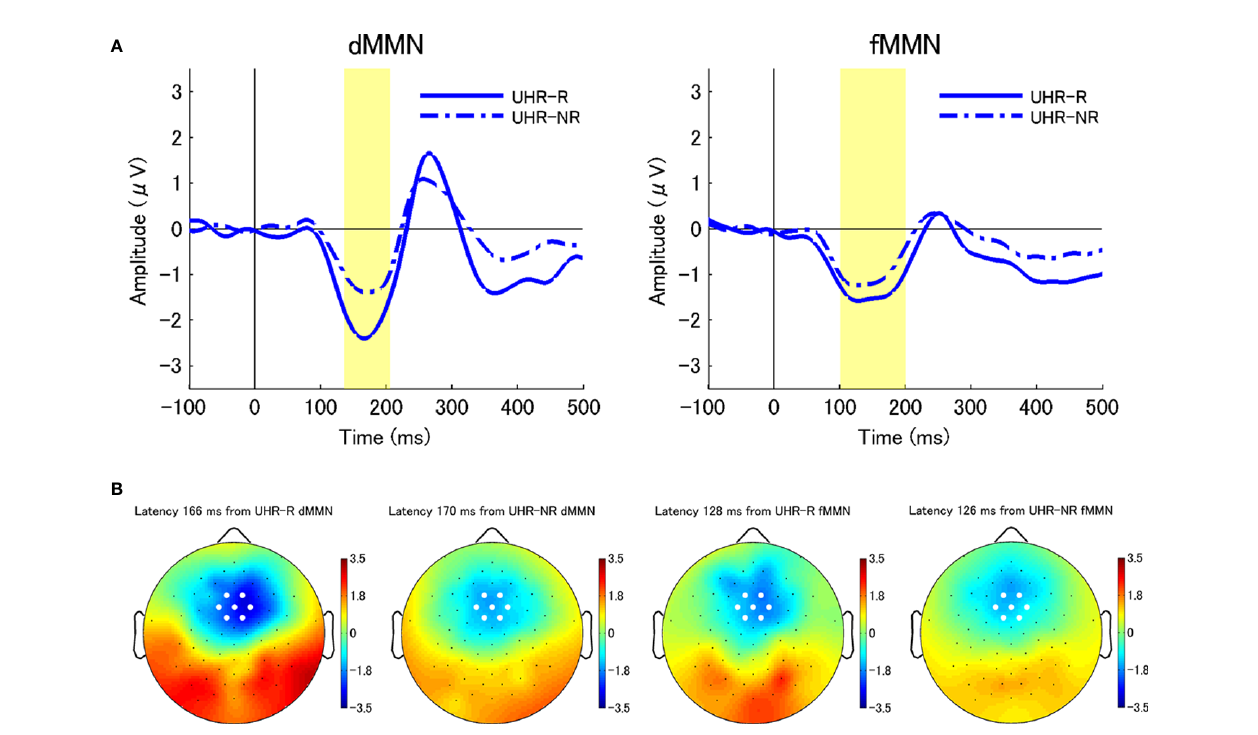
FIGURE 2 | (A) The average waveforms for duration mismatch negativity (dMMN; left) and frequency mismatch negativity (fMMN; right) at the seven electrodes around the frontocentral electrode (FCz) at baseline (Time 1) in individuals at ultra-high risk for psychosis (UHR) who achieved remission (remitters) (UHR-R; remitted at Time 2; N = 6; blue solid line) and those who did not (non-remitters) (UHR-NR; not remitted at Time 2; N = 18; blue chain line). There were signi fi cant between- subgroup differences in the dMMN amplitudes at the.05 level. (B) Two-dimensional topographic maps of the latency of peak amplitudes of dMMN (left) and fMMN (right) in both subgroups. The latency of the peak amplitudes were 166 ms (dMMN, UHR-R), 170 ms (dMMN, UHR-NR), 128 ms (fMMN, UHR-R), and 126 ms (fMMN, UHR-NR), respectively. White circles represent the seven electrodes around the FCz.